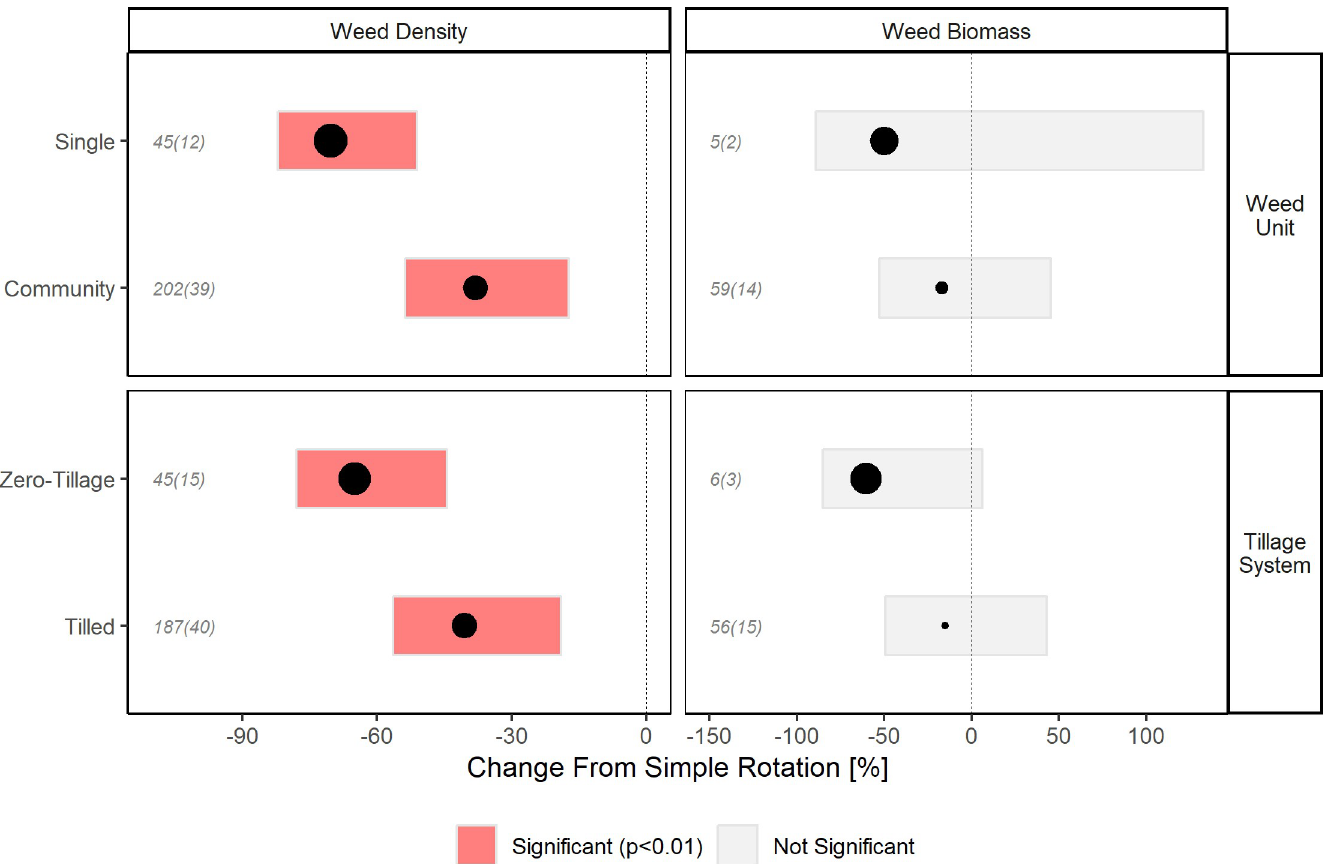
Fig 5. Weed density and biomass responses to increased rotational diversity as affected by weed measurement unit and tillage system. Mean values (point sizes scaled to absolute values), 99% confidence intervals, and number of observations (italics) and number of studies (italics, parentheses), dotted line represents no change, note different x-axis